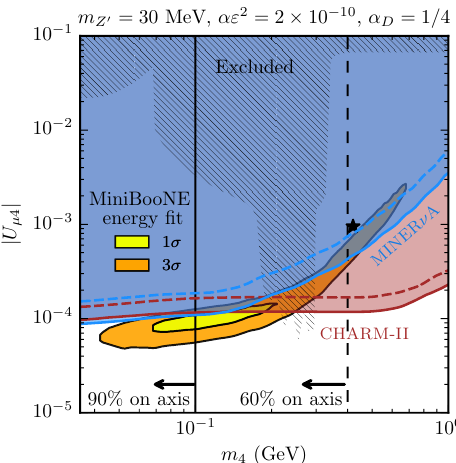
Figure 9.4: Constraints in the dark neutrino parameter space. New constraints are shown as light shaded regions: blue for Minerva and cherry-red for CHARM-II. The preferred region to explain the MiniBooNE excess energy distribution is shown in yellow for the one and three sigma regions. The dashed vertical line signals the value of m for which the angular distribution of the MiniBooNE excess is also a good 4 fit. The benchmark point of [ 200 ] is shown as a black star. Other relevant assumed parameters are written above the plot; changing these parameters does not change the relationship between preferred signal regions and constraints as they both scale approximately the